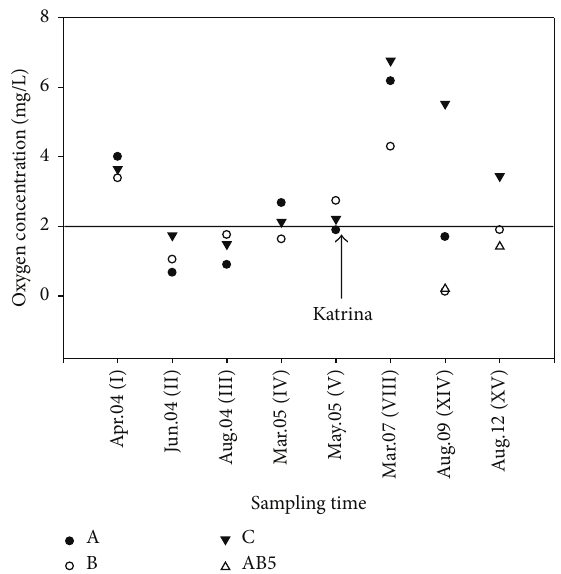
Figure 2: Near-bottom oxygen concentrations at each sampling site (A, B, C, and AB5 in Figure 1) from April 2004 to August 2012, with the horizontal line indicating the 2mg/L hypoxia threshold. Concentrations below 2 mg/L were considered hypoxic, whereas those below 1mg/L were categorized as “severe hypoxia.” “Katrina” was a major hurricane that passed through the area several months after the 2005 sampling.